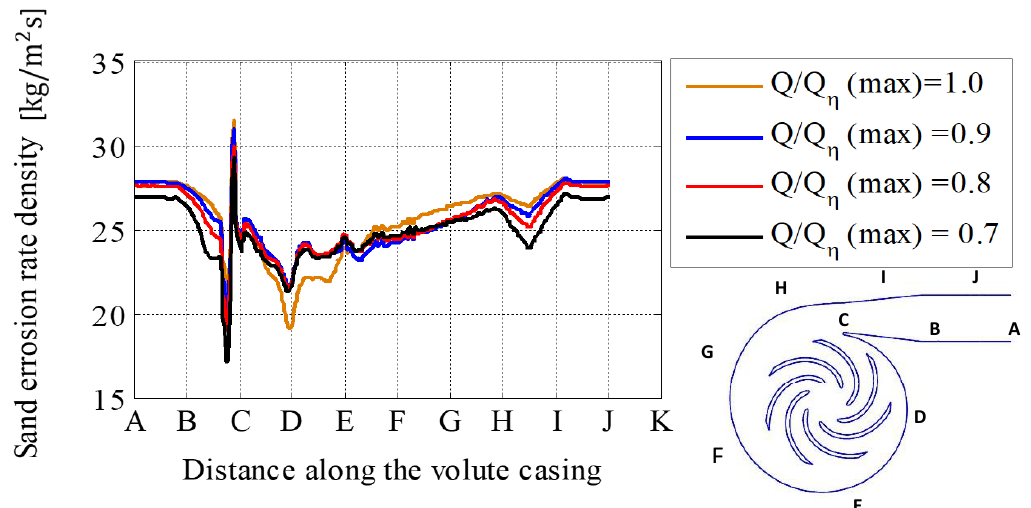
Figure 13. Variation of erosion rate density along the walls of casing with corresponding flow rates.